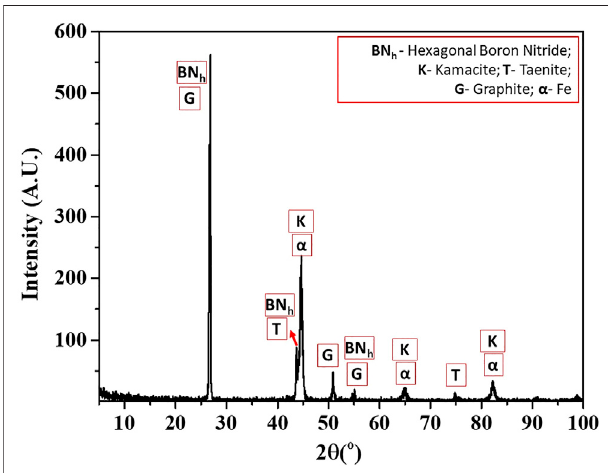
FIGURE 3 | X-ray diffraction pattern obtained from the surface of the Ni- G sample.